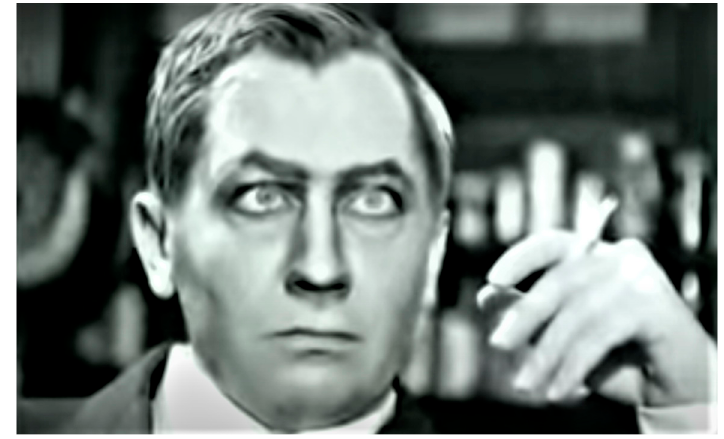
Figure 16. Vlad Mamyshev-Monroe as Stirlitz in Café Elefant .